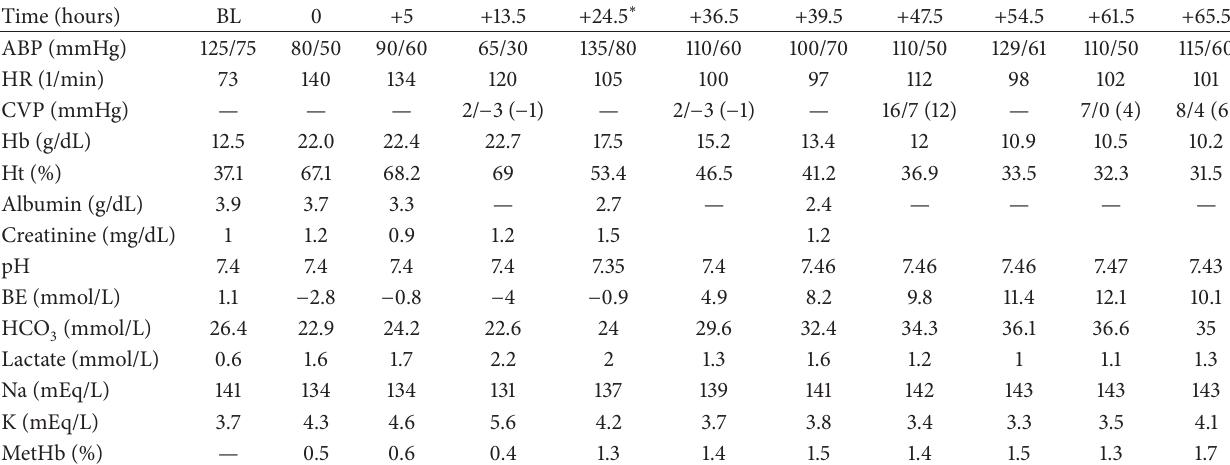
Table 1: Time course of hemodynamic and laboratory parameters at baseline and during the second acute